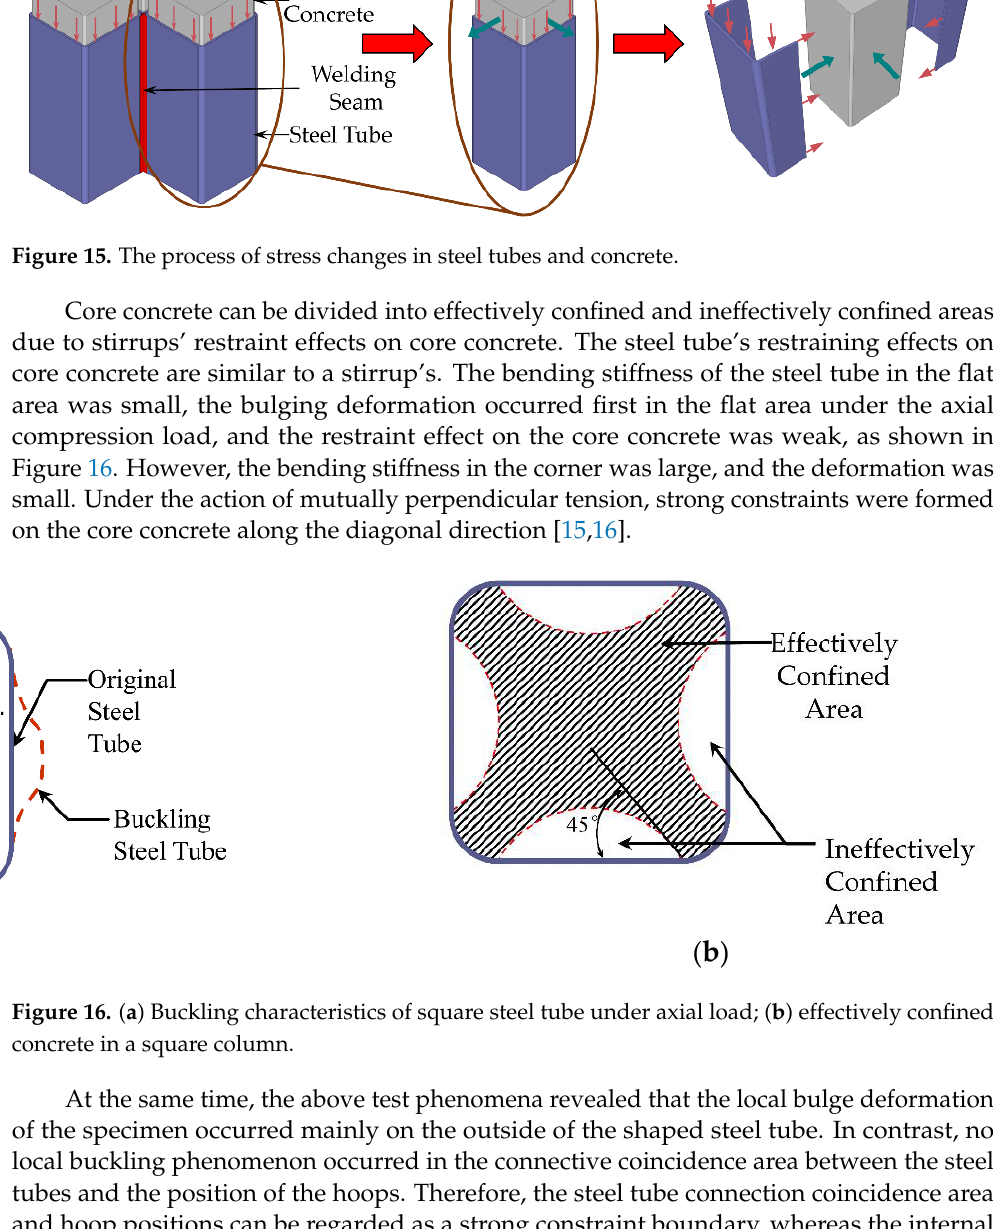
( d ) Figure 14. Poisson’s ratio of the steel tube ( a ) A2-T of HL-1; ( b ) B-T of HL-1; ( c ) A2-T of WL-1; ( d ) D-B of HL-2. 3.6. Bearing Mechanism At the start of the loading process, the steel tube and concrete mainly assumed the longitudinal compressive stress. At that time, the two worked independently, and the combined action had not yet occurred. The bearing capacity of the specimen can be re- garded as the superposition of the two, and the specimen will be in a state of elasticity. With continuous loading, the micro-cracks in the concrete continued to develop, and the Poisson’s ratio continued to increase. The concrete was in the stress state of longitud i- nal compression, circumferential and radial tension. When the transverse deformation of the concrete exceeded the transverse deformation of the steel tube, the steel tube restricted the concrete, and the concrete changed to triaxial compression. A plane stress state of cir- cumferential tension and longitudinal compression could be applied to the steel tube. The steel tube surface of the stub column specimen appeared to swell locally as the loading progressed, the growth rate of the load slowed down, and the axial compression stiffness decreased. The specimen was in an elastic – plastic state. For the slender column, the spec- imen was susceptible to lateral deformation after entering the elastic – plastic phase, whereas the P- δ second-order effect caused the additional bending moment to increase rapidly. When the additional bending moment was the same as the resisting moment of the section, the load reached the maximum value. During the damage phase, the steel tube’s local buckling of the stub column was further ex tended, and some of the tubes